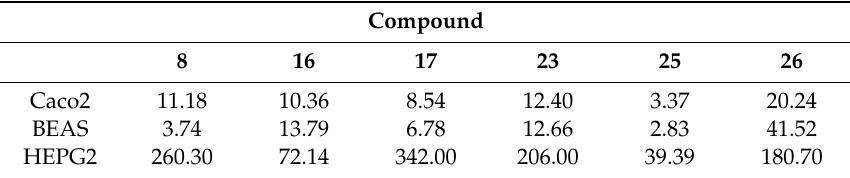
Figure 2. Graphical representation of the therapeutic index of the more active and less toxic berberine derivatives. Best berberine derivatives were selected based on their high antimicrobial activity and low toxicity. Dose-dependent effects of the selected derivatives in term of human cell toxicity and antibacterial activity against S. aureus were plotted using the Graph Pad Prism software. Results are expressed as means +/ − SD with n = 3. Table 3. Determination of the therapeutic index of the more active and less toxic berberine derivatives. Best berberine derivatives were selected based on their high antimicrobial activity and low toxicity. The therapeutic index of each derivative was calculated by dividing its IC 50 value on a specific human cell type by its MIC value on S. aureus .